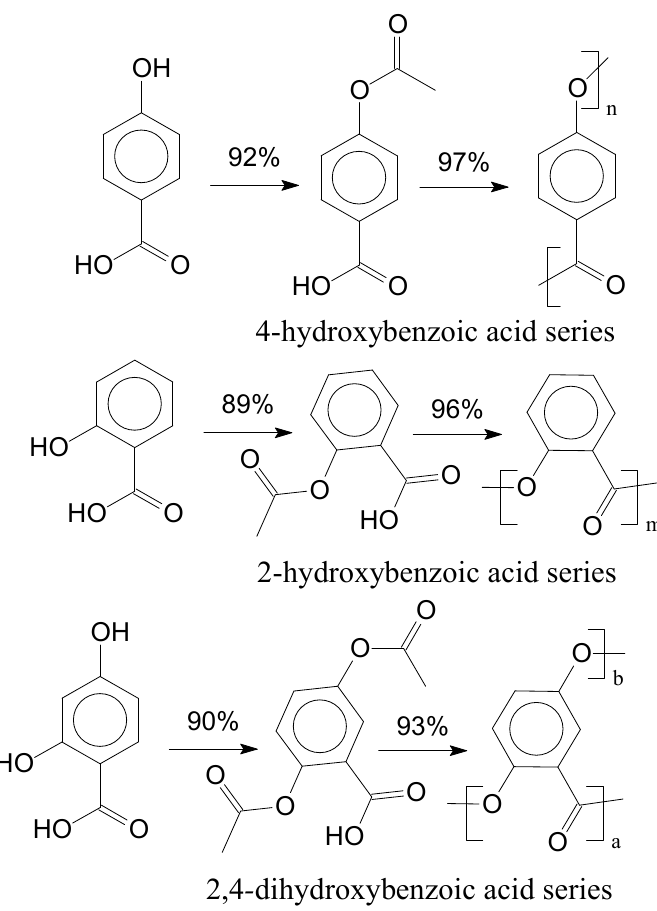
Figure 5. Acetylation and polymerization of aromatic acids and their yields.